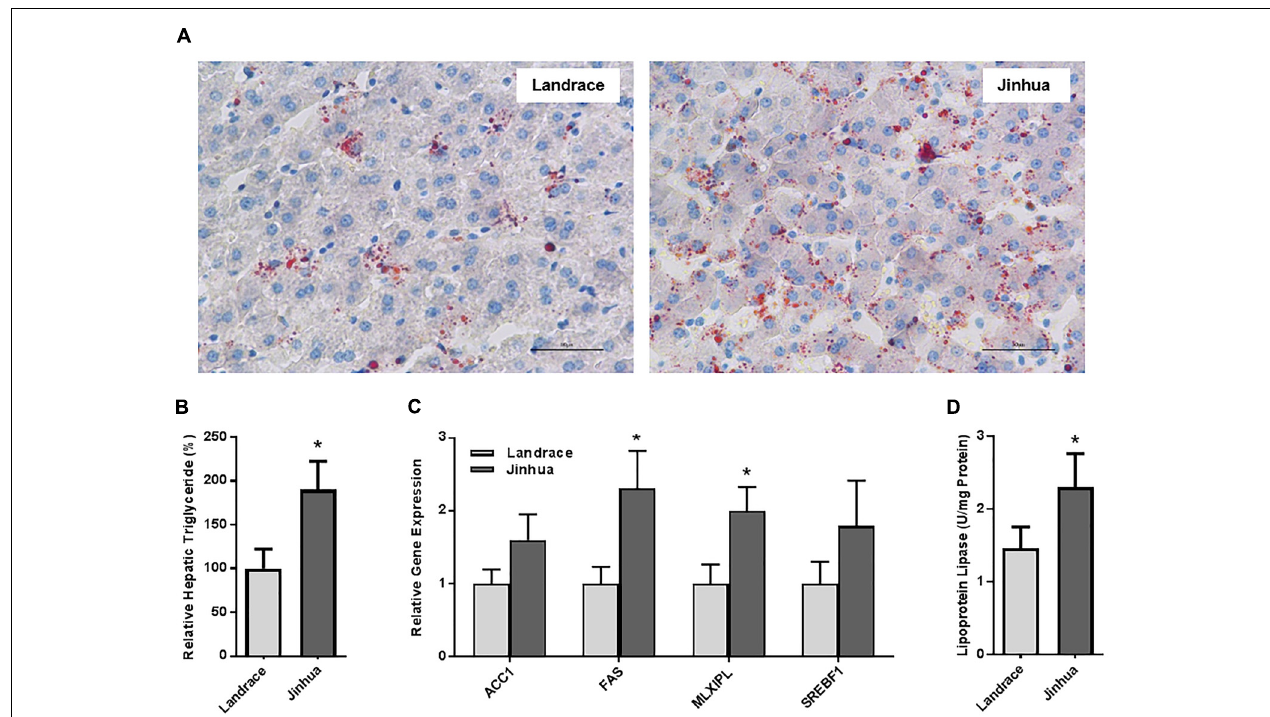
FIGURE 1 | Fat deposition and lipogenesis in the liver of Landrace and Jinhua pigs. (A) Representative pictures of the liver sections of Landrace and Jinhua pigs stained with Oil Red O. Neutral lipids appear in red (magnification: 400 × ). (B) Relative triglyceride content (%) in the liver of Landrace and Jinhua pigs. (C) Relative expression levels of several major lipogenic genes in the liver of two breeds of pigs. (D) The lipoprotein lipase activity in the liver of Landrace and Jinhua pigs. The results were shown as means ± SEM of 10 pigs. ∗ P < 0.05 (by unpaired Student’s t